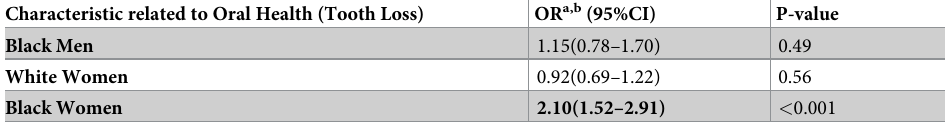
Table 2. Odds ratio of tooth loss for the oral health outcome between sexes and race in the population with the IPVS and age conditions, ISACamp 2014/15. Characteristic related to Oral Health (Tooth